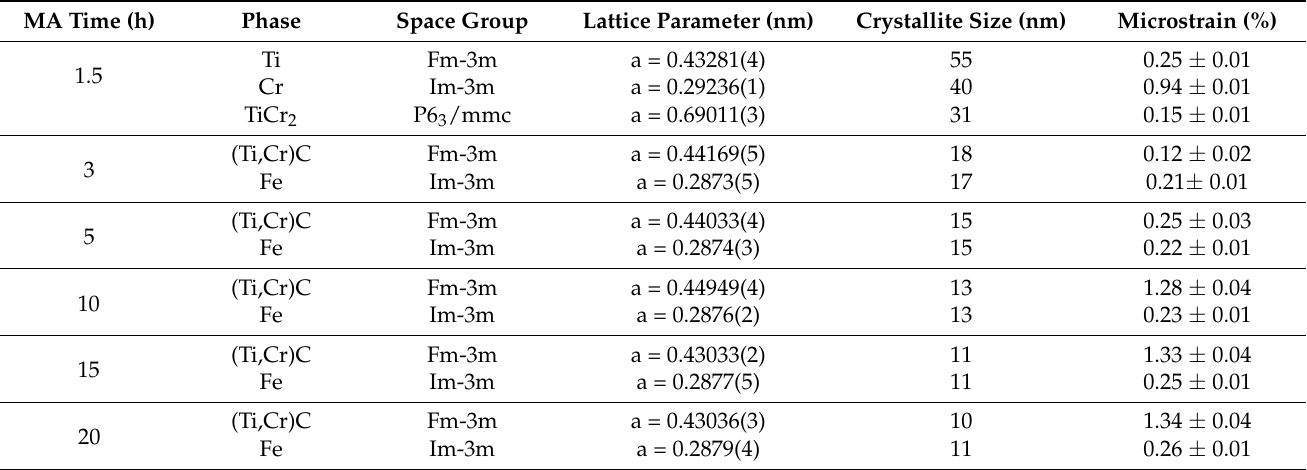
Table 1. The results of quantitative analysis of microstructural parameters derived from Rietveld refinement for XRD patterns of samples MA for different